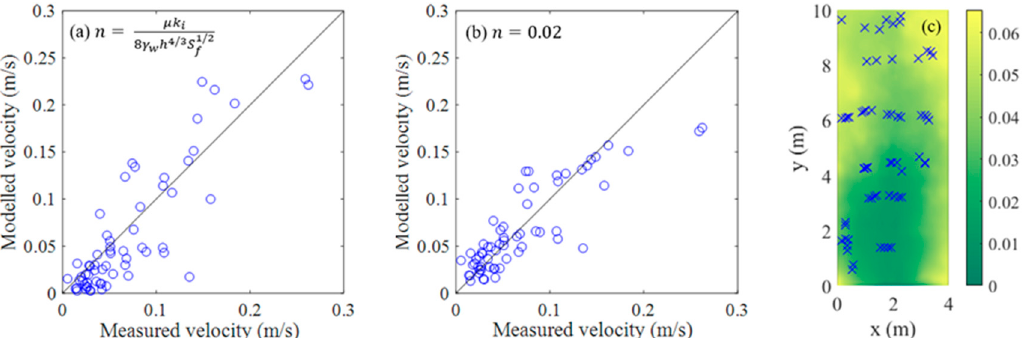
velocity (m/s) using ( c ) n = 0.02 and ( d ) Equation (16)